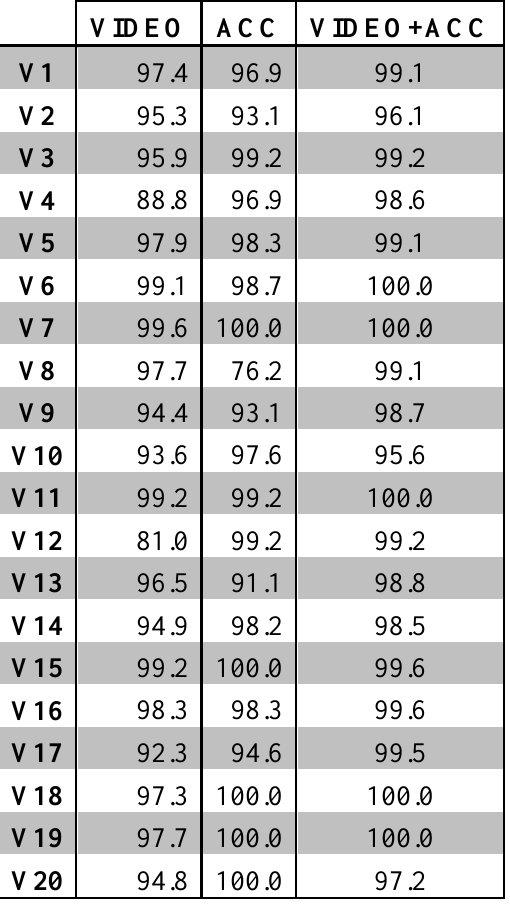
Table 4. Recognition correctness of all examined physical activities for each of the volunteers (V1 ÷